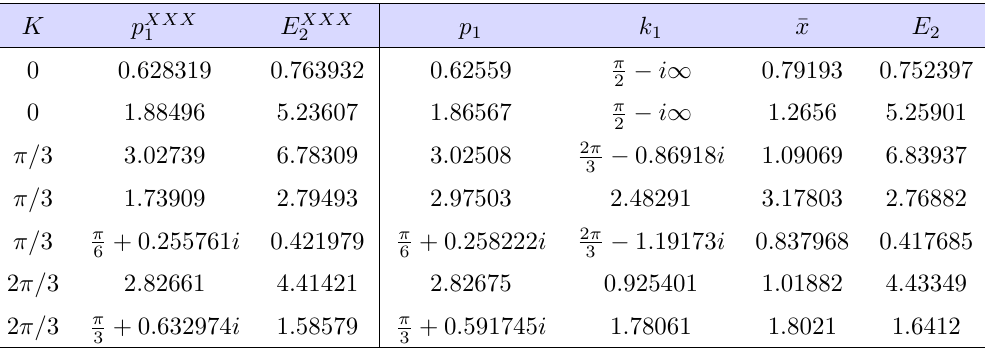
Table 5 . Length-6, κ = 0 . 9 twisted XZ chain: some of the momenta appearing in the twisted XZ -sector 2-magnon wavefunction for the case L = 6 , κ = 0 . 9 , with the corresponding ones for the twisted XXX model for comparison. The p k 2 . As explained in the main text, ¯ x is the proportionality constant between the first and second